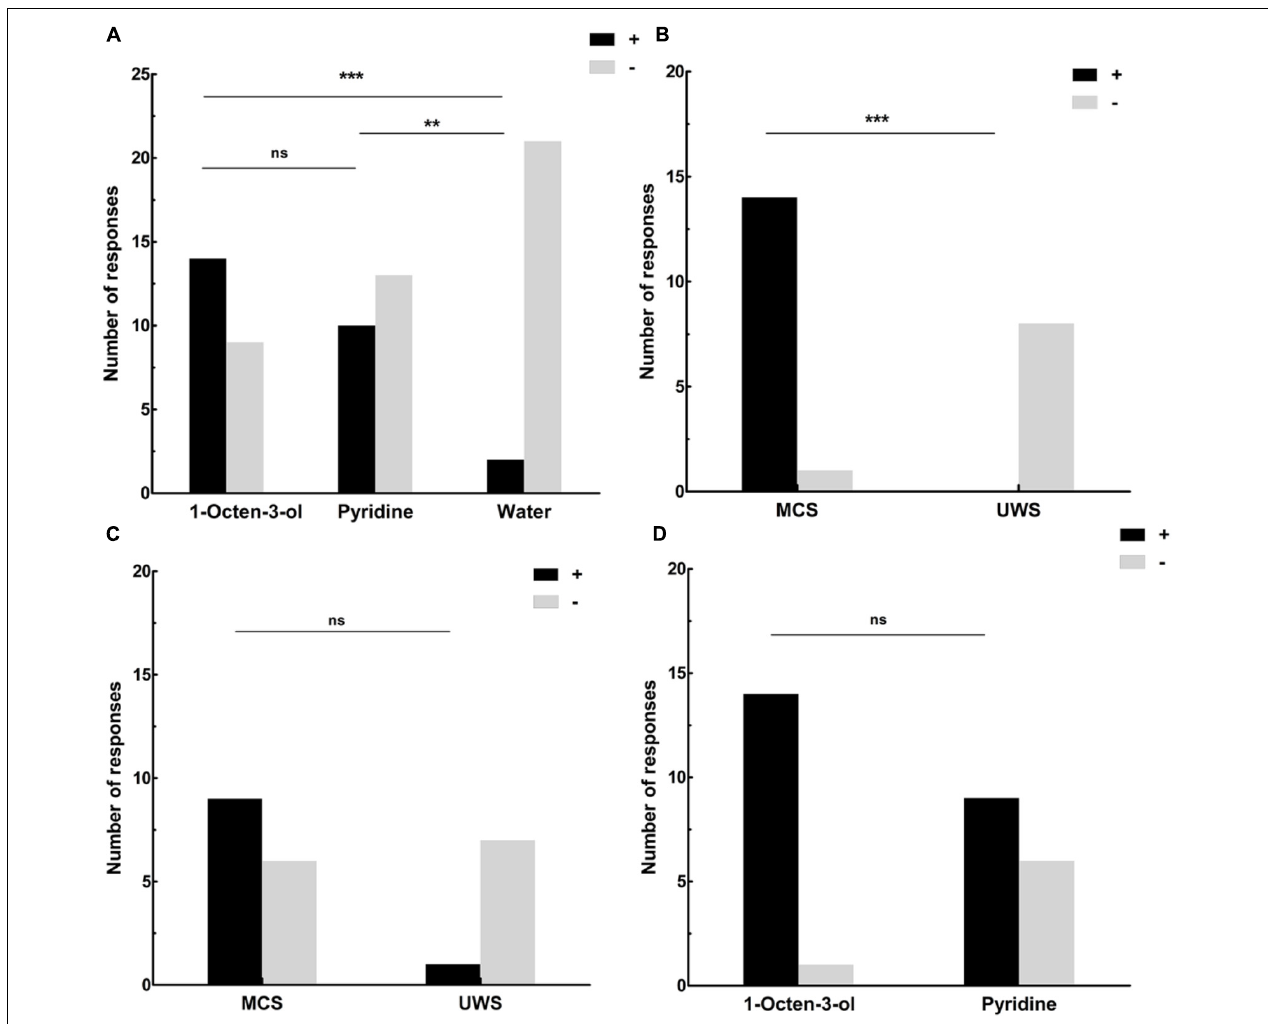
FIGURE 1 | (A) The number of DOC patients’ responses to the olfactory and water stimuli. Fourteen showed behavioral responses to the 1-Octen-3-ol stimulus, 10 showed behavioral responses to the pyridine, and 2 showed behavioral responses to the water stimulus. (B) The number of responses for MCS and UWS patients to the 1-Octen-3-ol stimulus. No UWS patients showed a behavioral response to the 1-Octen-3-ol stimulus, and 14 MCS patients showed an obvious behavioral response to the 1-Octen-3-ol stimulus (93.3%). (C) The number of responses for MCS and UWS patients to the pyridine. One UWS patient showed behavioral response to the pyridine (12.5%), and nine MCS patients showed an obvious behavioral response to the pyridine (60%). (D) The number of responses to the 1-Octen-3-ol and pyridine stimuli for MCS patients. Fourteen MCS patients showed an obvious behavioral response to the 1-Octen-3-ol stimulus (93.3%). Nine